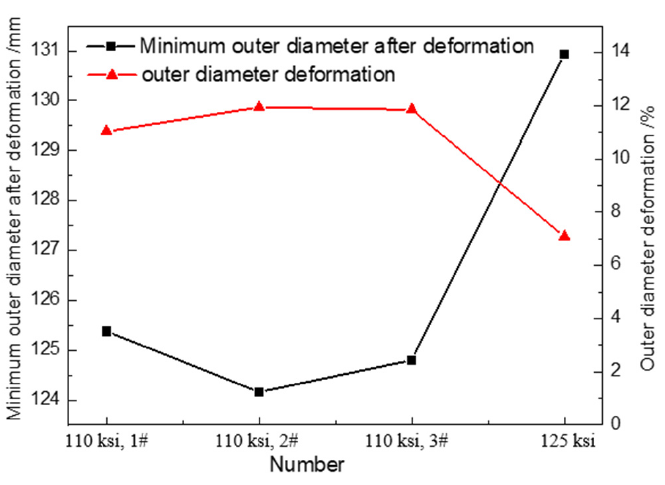
Figure 6. The minimum outer diameter and deformation of cement-sheath casing after shearing.